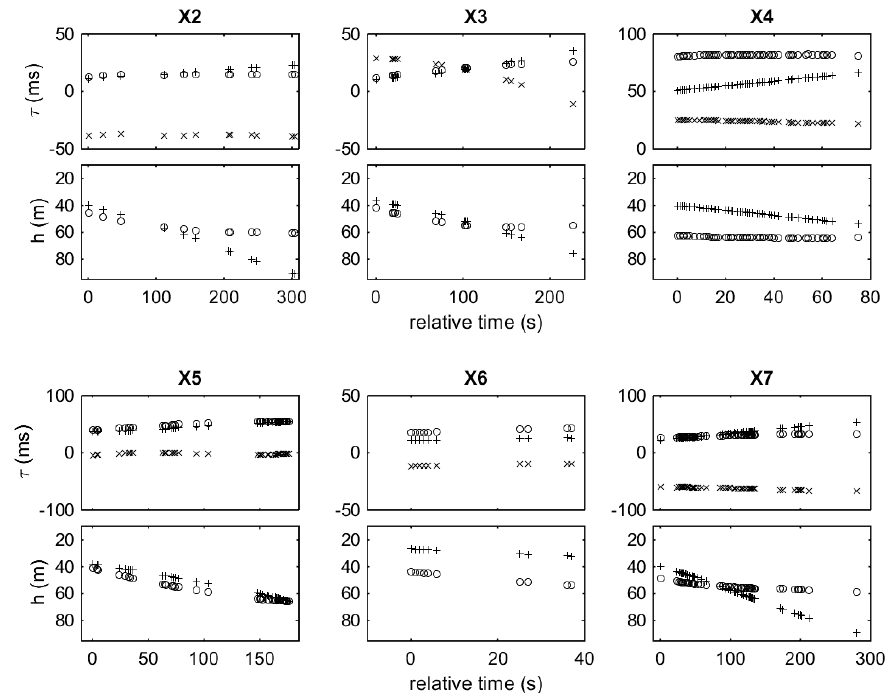
Figure 14. TDOAs of sperm-whale signals and hydrophone depths during stations X2–X7 of the deep-water experiment on 7 June 2015 aiming at the localization of sperm whale X for front hydrophone ( ◦ ), rear hydrophone (+) and τ 21 ( ×